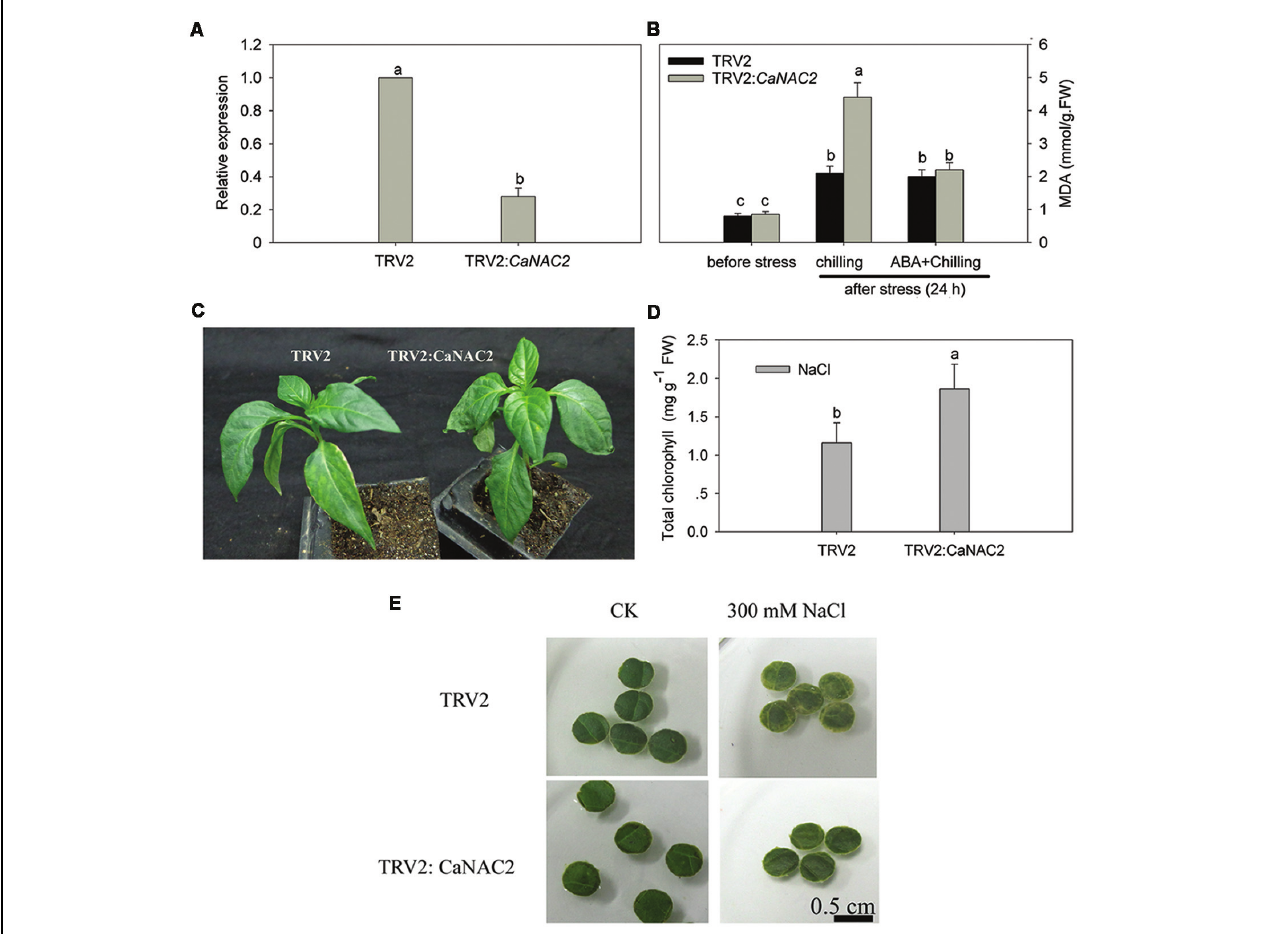
FIGURE 4 | CaNAC2 -silenced pepper plants. (A) The expression of CaNAC2 in gene-silenced pepper (TRV2: CaNAC2 ) cv P70 and control plants (TRV2:00) were tested at 45 days after inoculation; (B) Effect of ABA application and chilling stress on lipid peroxidation (MDA) content in CaNAC2 -silenced pepper seedlings. (C) Phenotypes analysis of the CaNAC2 -silenced and non-silenced pepper seedlings under 6 ◦ C cold stress for 6 h. (D) Chlorophyll contents of leaf disks. (E) Leaf disks phenotypes. Leaf disks from the gene-silenced plants were floated in 300 mM NaCl solutions for 72 h at 25 ◦ C. Bars with different lower case letters indicate significant differences compared to empty vector control leaves (Student’s t -test, p ≤